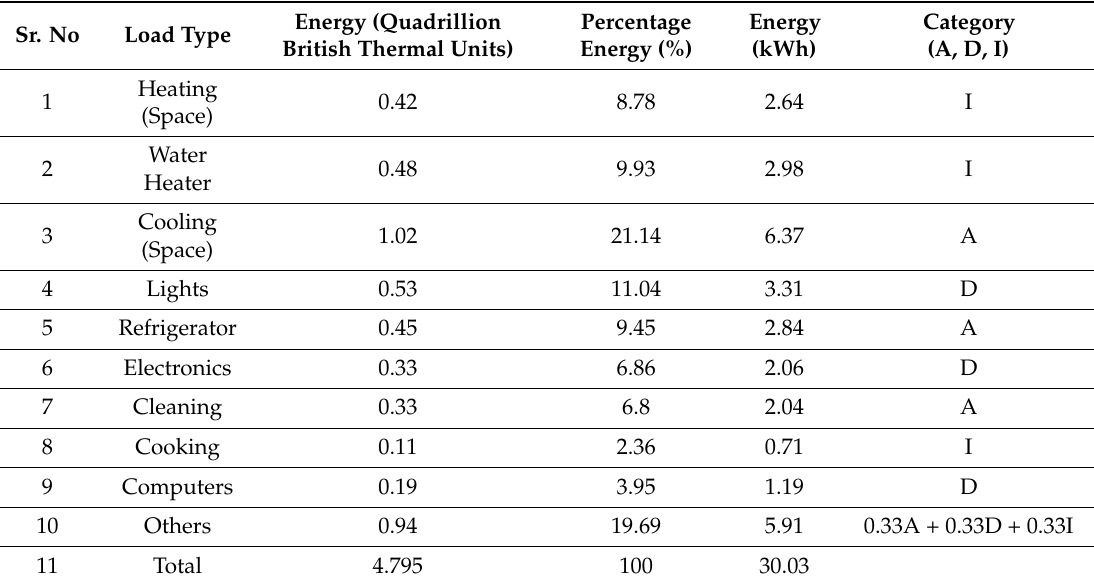
Table 1. Residential Energy